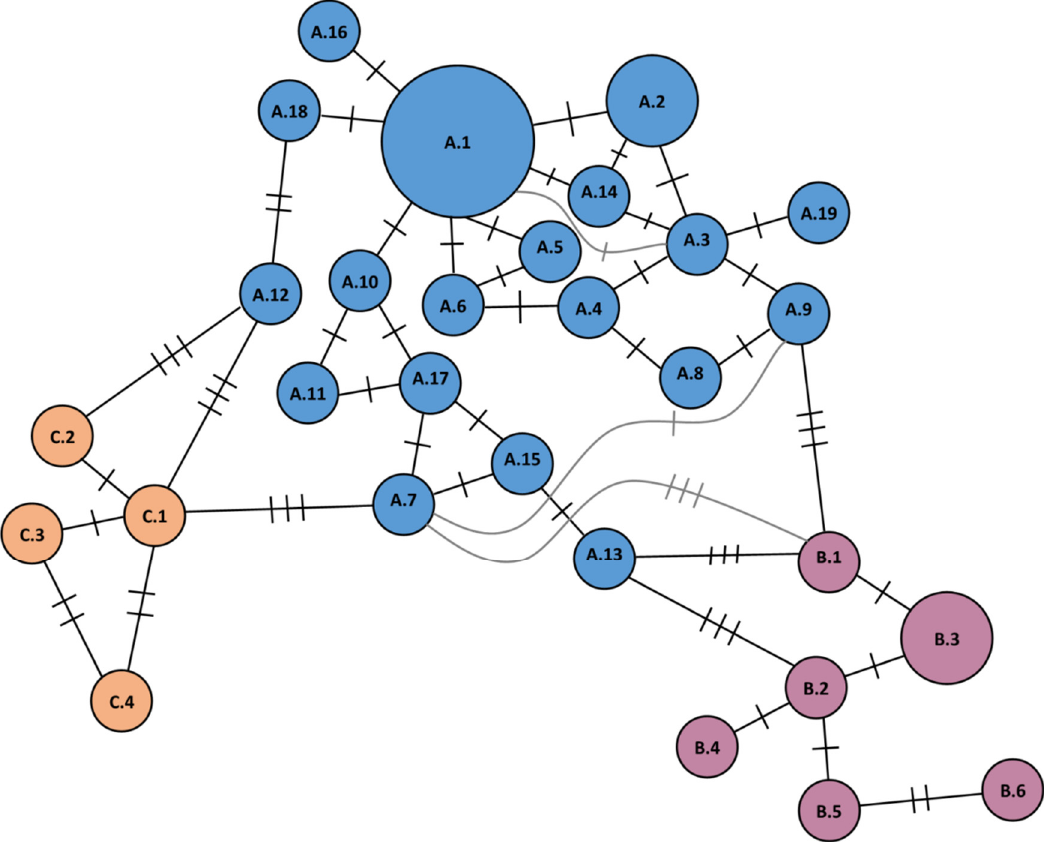
Figure 1. Minimum spanning tree of Q. rubra haplotypes. Each haplotype is linked to the others by the minimum number of marker differences necessary. Each crossbar represents one mutation separating haplotypes. The area of the circle reflects sample sizes, where the largest circle represents the most common haplotype A.1 found in 690 trees, and the second largest circle represents two haplotypes A.2 and B.3 found in 126 and 167 trees, respectively (see also Table 2).